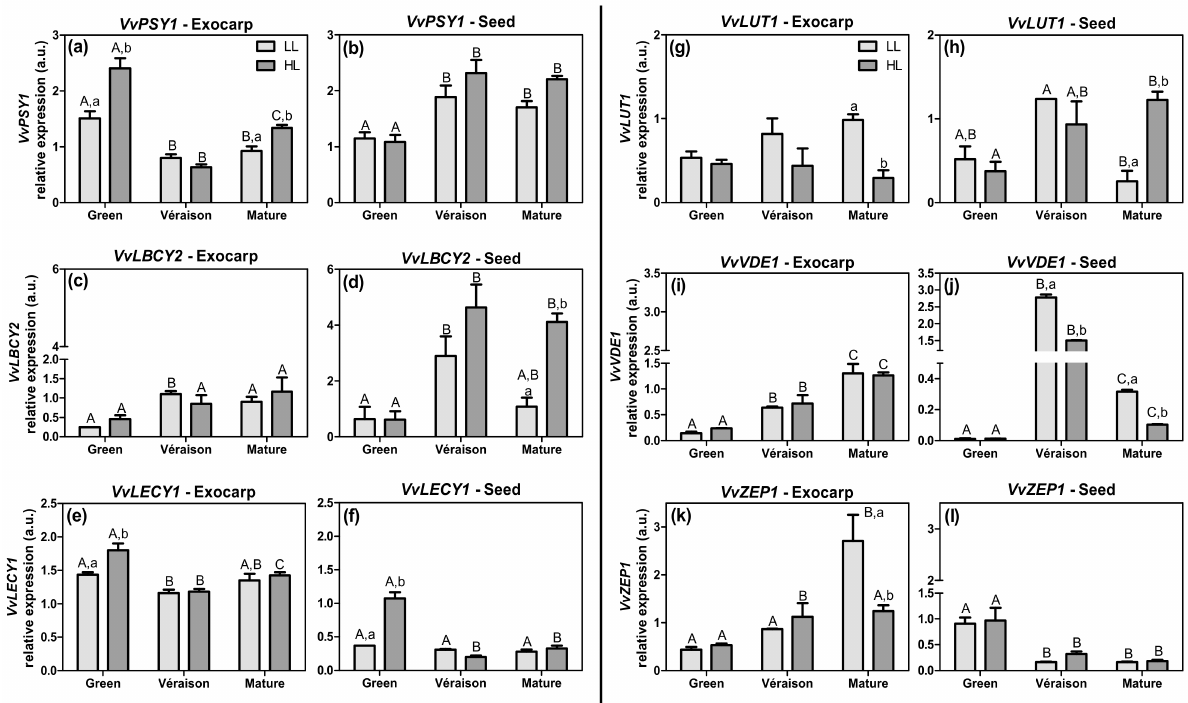
Figure 2. Relative expression in arbitrary units (a.u.) of transcripts of phytoene synthase 1 ( VvPSY1 ) ( a , b ), lycopene beta-cyclase 2 ( VvLBCY2 ) ( c , d ), lycopene epsilon cyclase 1 ( VvLECY1 ) ( e , f ), carotene epsilon-monooxygenase or lutein- deficient 1 ( VvLUT1 ) ( g , h ), violaxanthin de-epoxidase 1 ( VvVDE1 ) ( i , j ), and zeaxanthin epoxidase 1 ( VvZEP1 ) gene ( k , l ) in exocarp and seeds, from berries grown at two distinct light microclimates (LL and HL), and at three developmental stages (green, v é raison , and mature), as determined by real-time qPCR. Expression levels are normalized to the mean expression of reference genes VvACT1 and VvGAPDH . Statistical analysis (two-way ANOVA, p ≤ 0.05, n = 3) was applied after data Log(X+1) transformation. Statistical notation: capital letters refer to differences between developmental stages for the same microclimate, and lowercase letters refer to differences between microclimates for each stage. When the letters are omitted, it means that the respective factor did not have a significant